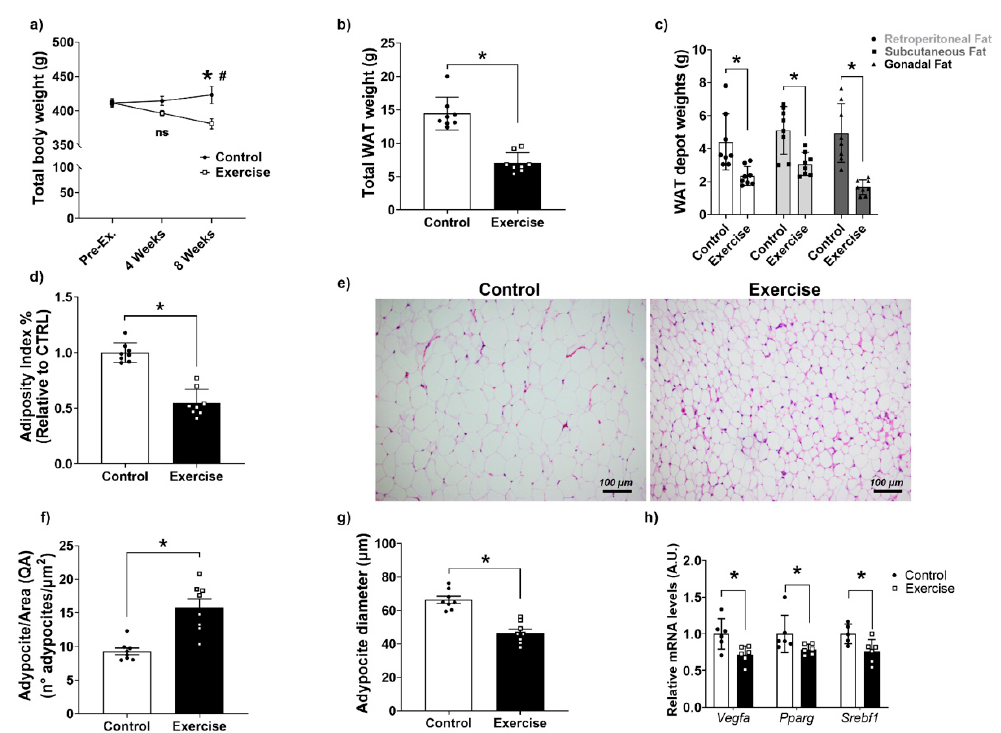
Figure 1. Aerobic exercise reduced body weight and adiposity in Wistar rats. ( a ) Body weight; ( b ) Total WAT weight; ( c ) Weight of WAT depots; ( d ) Adiposity index; ( e ) WAT hematoxylin-eosin histology; stained with hematoxylin-eosin at 200x magnification; ( f ) Histomorphometry of numerical adipocyte density (QA); ( g ) Histomorphometry of adipocyte diameter; ( h ) mRNA levels of genes related to lipogenesis in WAT. Pparg: Peroxisome proliferator-activated receptor-gamma; Srebf1: Sterol regulatory element-binding protein 1; Vegf: Vascular Endothelial Growth Factor. The data were expressed as the mean ± standard error of the mean ( n = 8 animals/group). • -Control group; ▫ –Exercise group. # Statistical difference intra-group related to the fourth week, and * Statistical difference between groups.